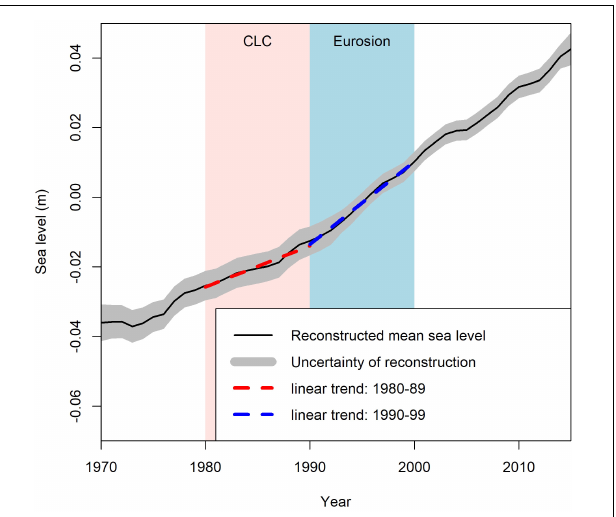
FIGURE 3 | Mean sea-level rise in the Bay of Biscay and English